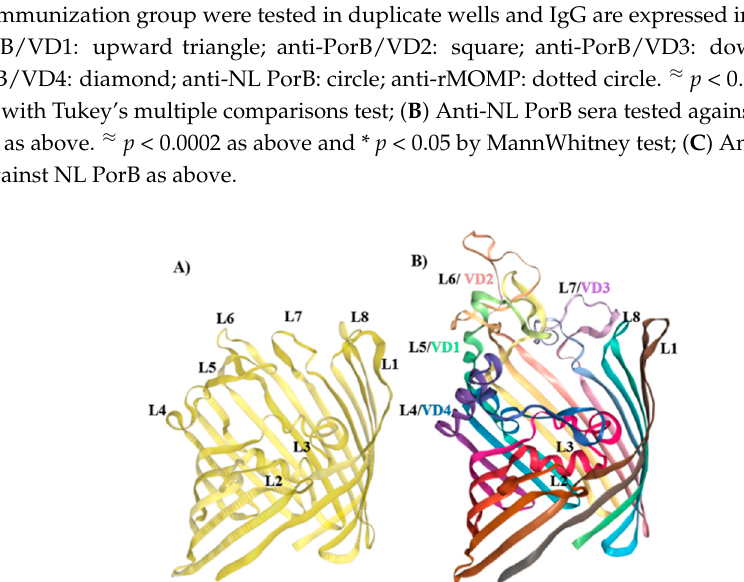
Figure A2. Molecular representation of NL PorB/multiple VDs. (A ) Cartoon of NL PorB monomer (side view) created with Swiss-Model server [63,64] and NGL Viewer 0.9.0 [65] based on the Nme PorB template (PDB ID 3WI4) [66]. Loops 1 through 8 are indicated; ( B ) Cartoon of the predicted PorB/VD1-VD2-VD3-VD4 monomer. PorB L1: dark brown; L2: light brown; L3: cherry; L4 replaced with MOMP L6 containing VD4: purple/blue; L5 replaced with MOMP L2 containing VD1: green/yellow; L6 replaced with MOMP L3 containing VD2: peach/pink; L7 replaced with MOMP L5 containing VD3: lavender; PorB L8: teal.